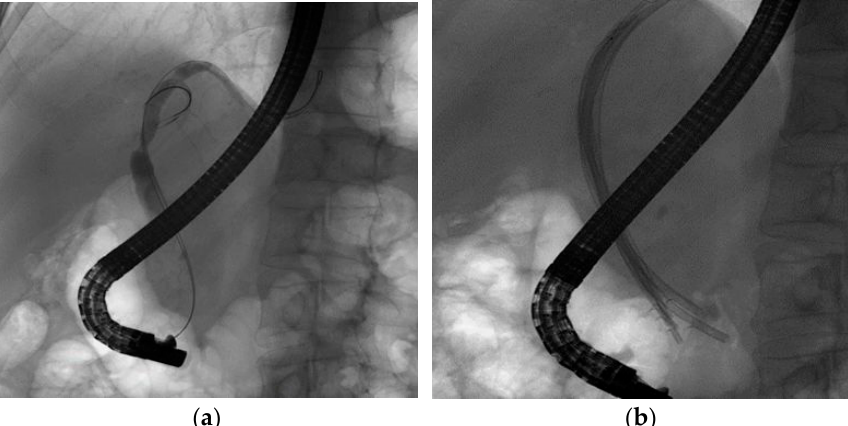
Figure 1. Cholangiogram of hilar biliary stenosis post OLT before ( a ) and after ( b ) multiple plastic stent insertion.